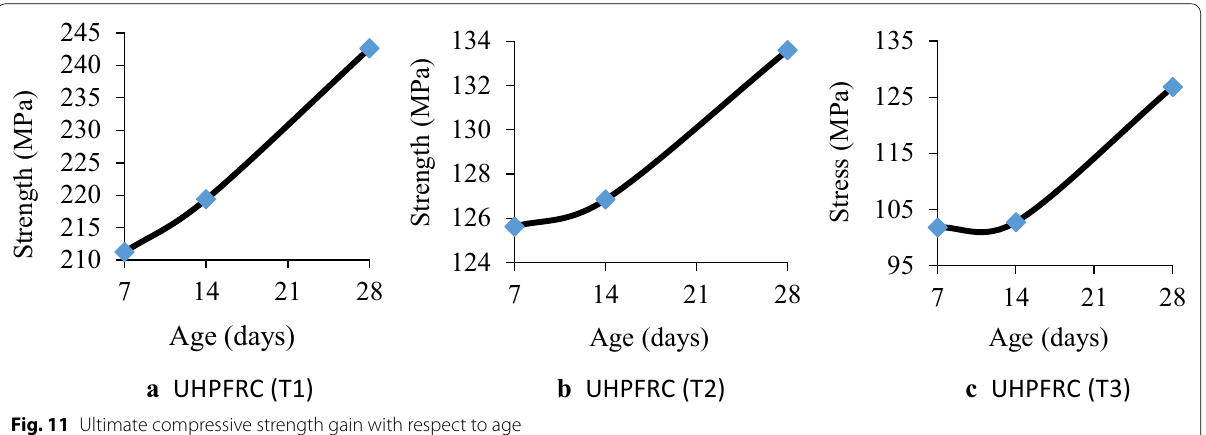
Fig. 11 Ultimate compressive strength gain with respect to age